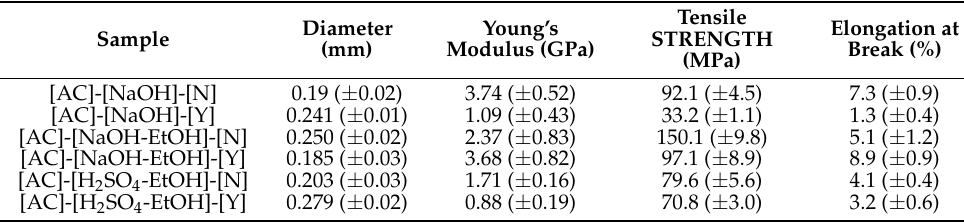
Table 6. Mechanical properties of wet spun monofilaments using acetic acid as the